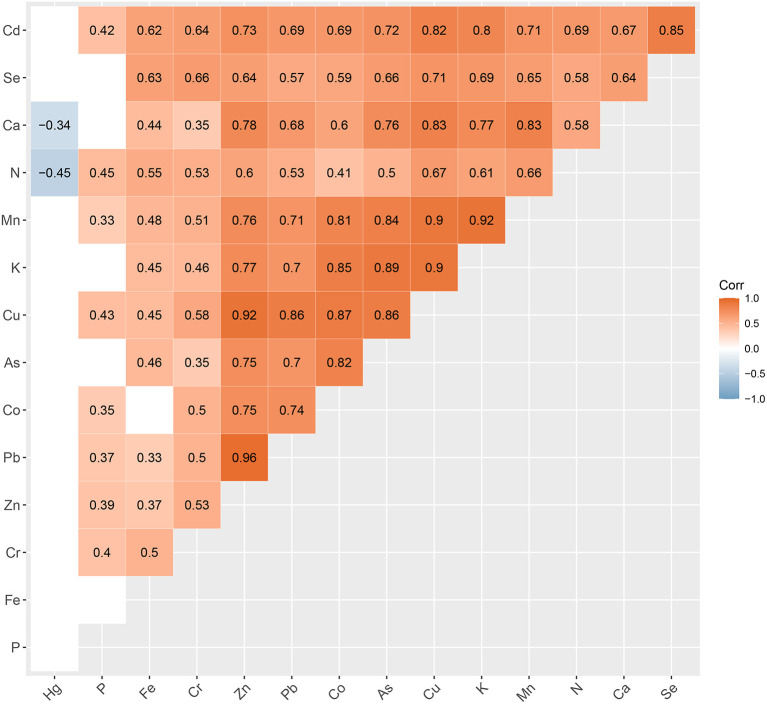
Correlation heat map of the 15 elements analyzed in our study. Levels of statistical significance p < 0.05 are not shown.